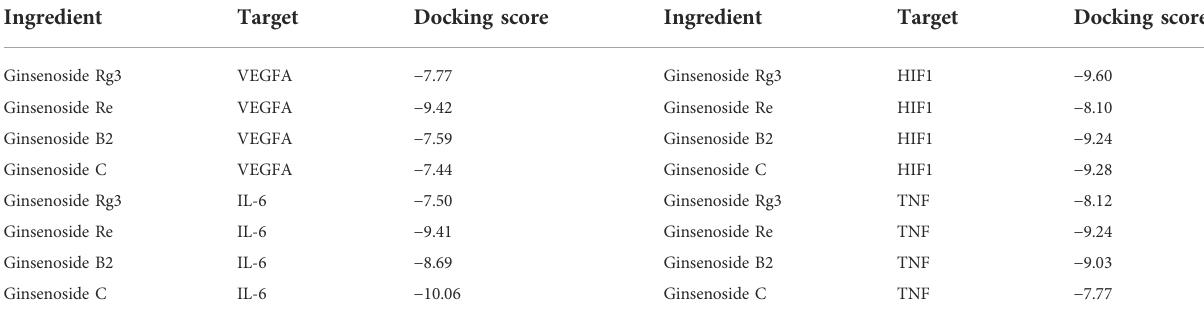
TABLE 3 Docking scores of selected components and